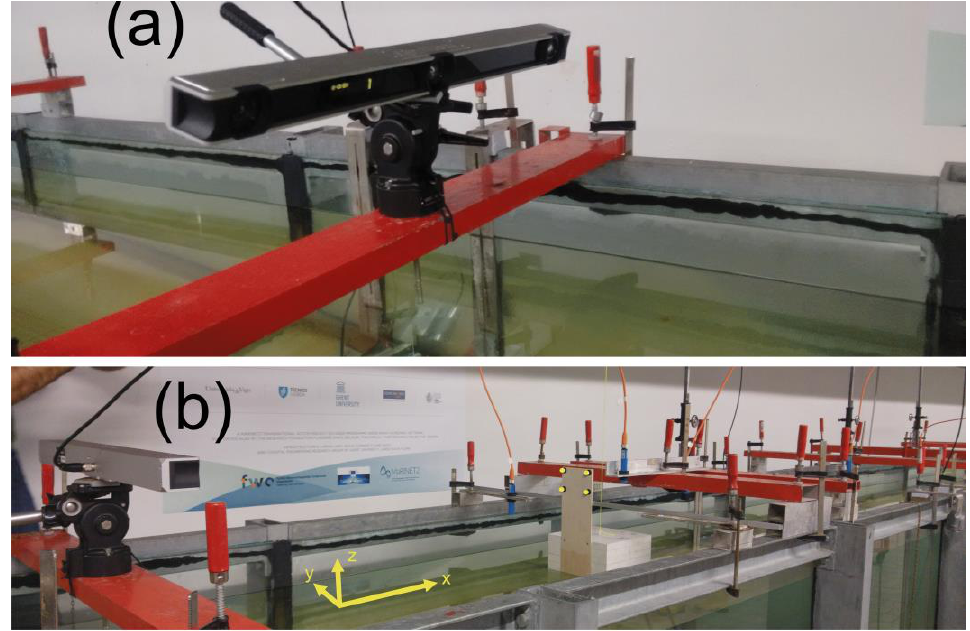
Figure 9. The OptiTrack video motion tracking system (VT): ( a ) the three cameras of the VT attached on a single axis; ( b ) the VT facing the four “ball” markers attached to the BOX model and sketch of the coordinate system used for the VT.